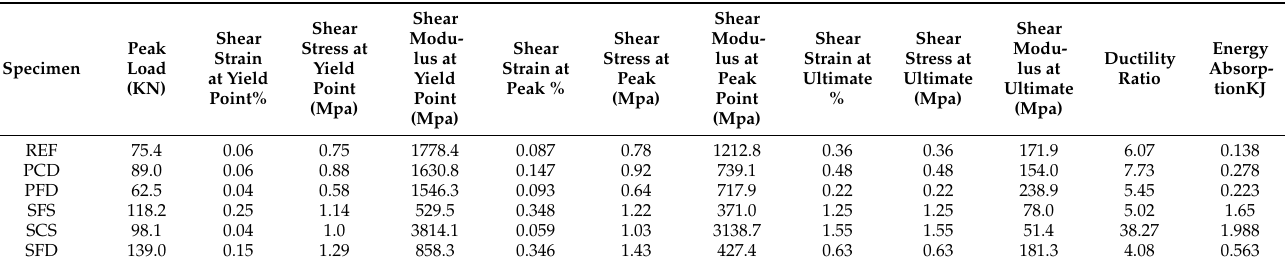
Table 2. Diagonal static cyclic compression test